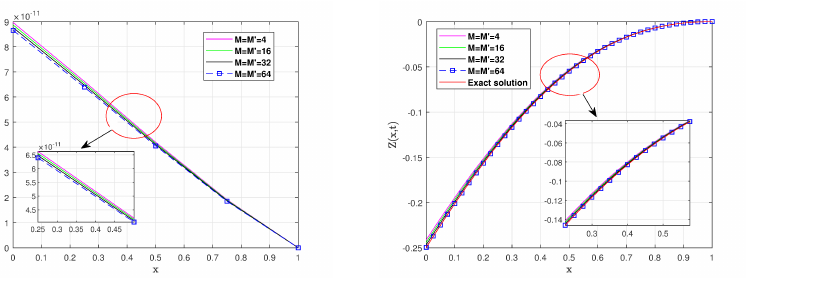
η 1 and η are presented in Table 4.